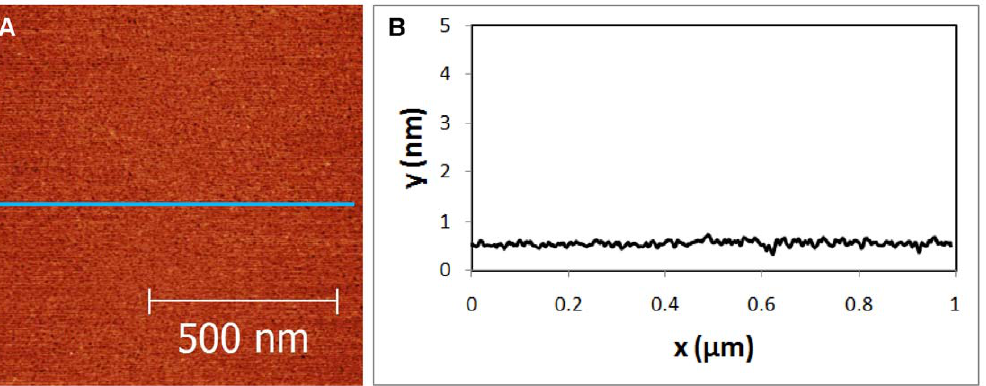
Figure 2. Topography of Mica/GaAl 12 sample. (A) AFM image of GaAl 12 adsorbed mica surface. (B) Cross sectional image along the blue line shown in (A).